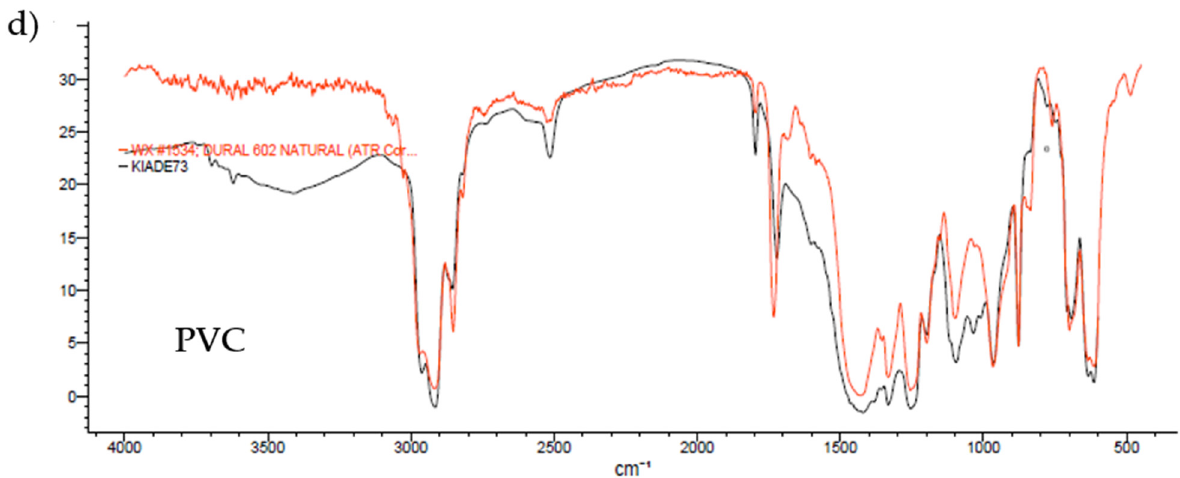
Figure 7. Example of Fourier transform infrared (FTIR) spectroscopy Analysis of abundant polymers found in this study: ( a ) Polyethylene Terephthalate (PET), ( b ) Polyethylene (PE), ( c ) Polypropylene (PP) and ( d ) Polyvinyl Chloride (PVC).